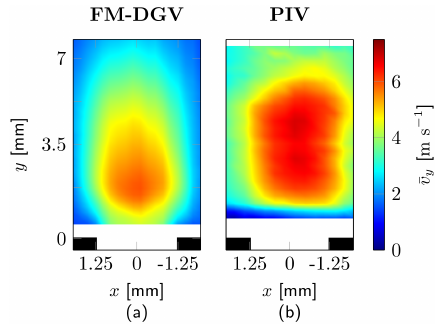
Figure 12. Amplitude of the sound-excited flow velocity oscilla- tions in y direction.